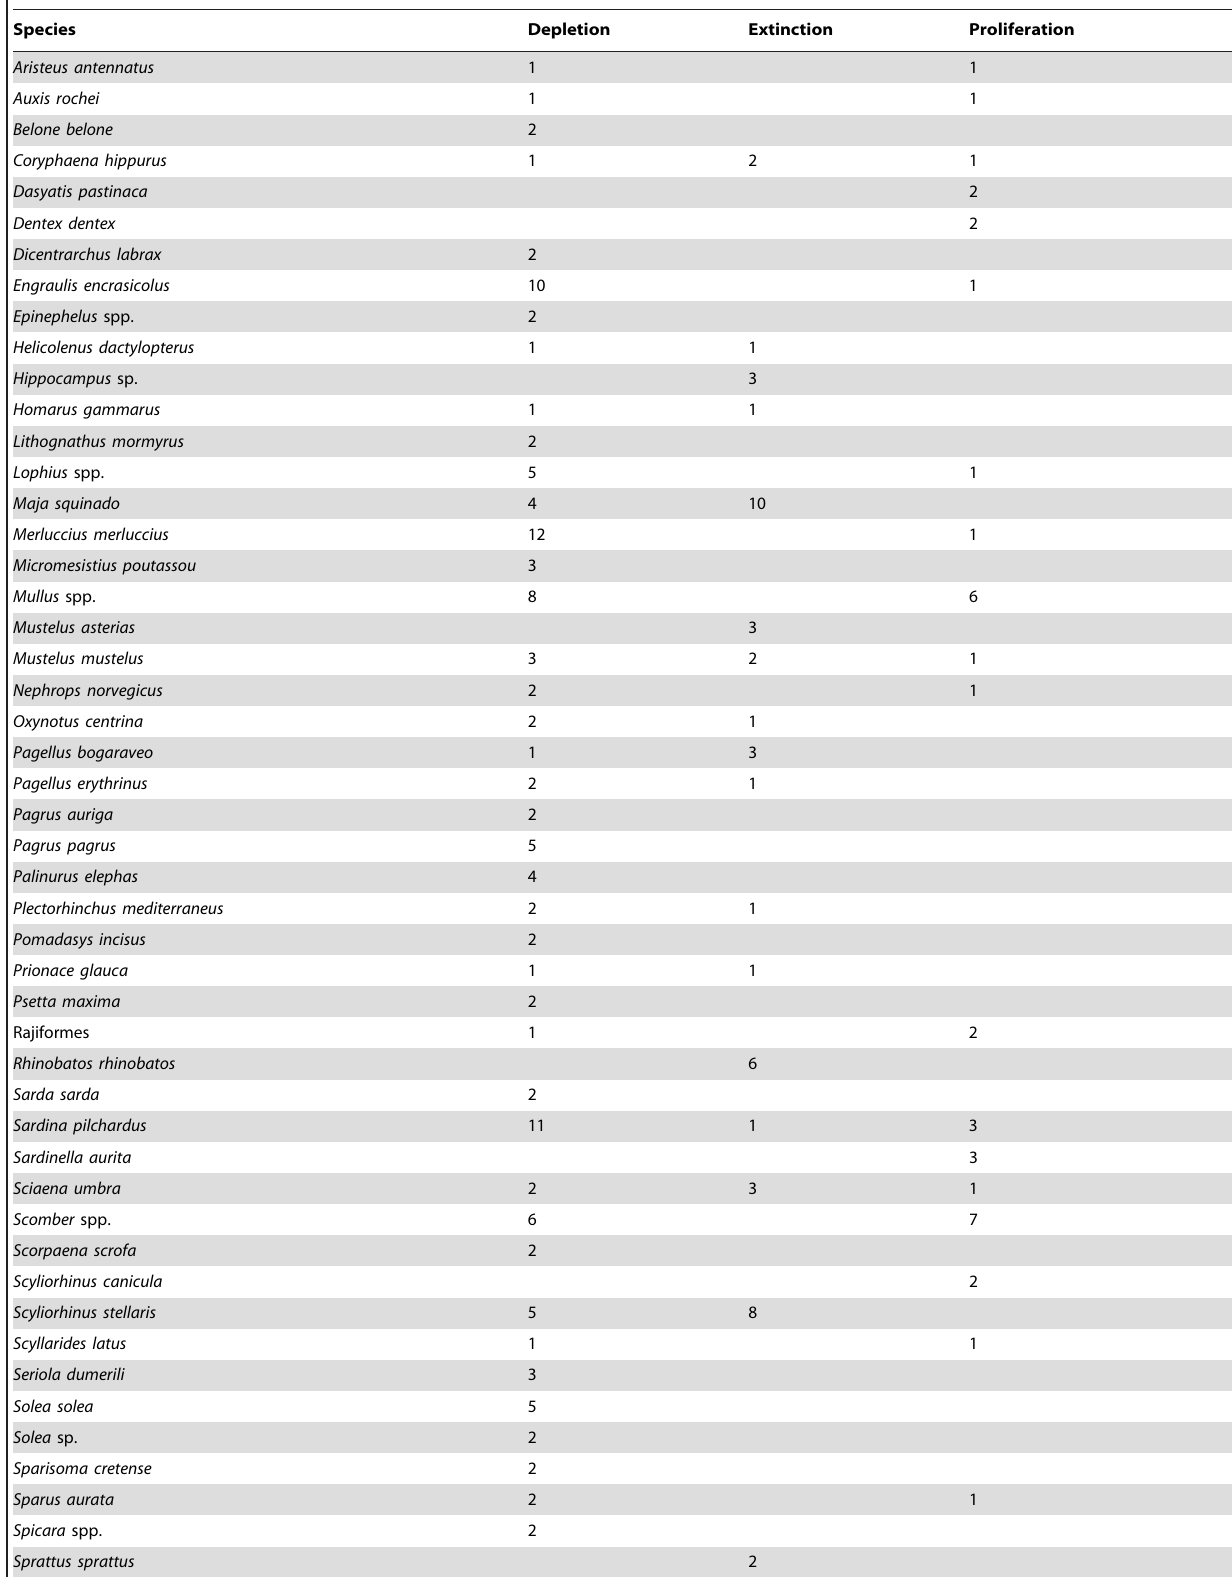
Table 2. Summary of taxa and groups listed by fishers as being depleted (D), locally extinct (E), and as having proliferated (P).